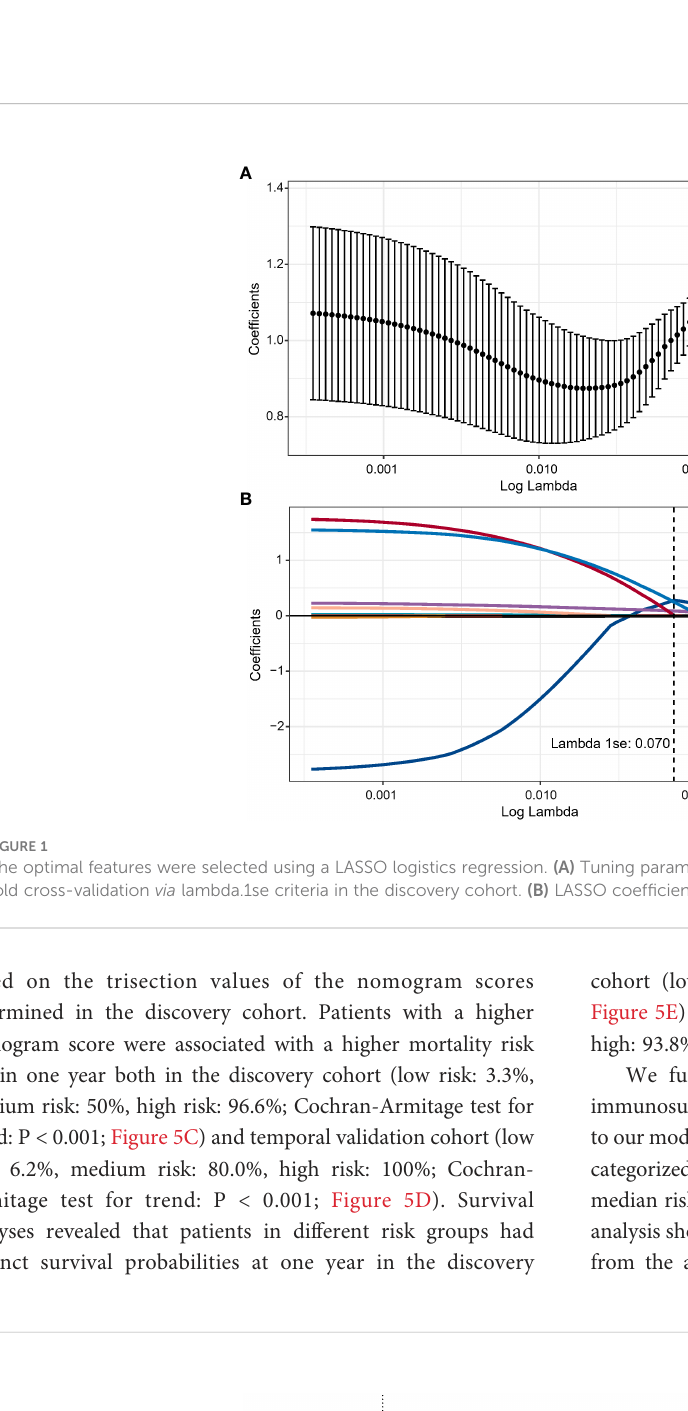
cohort (low vs. medium vs. high: 96.7% vs. 41.3% vs. 0%; Figure 5E) and temporal validation